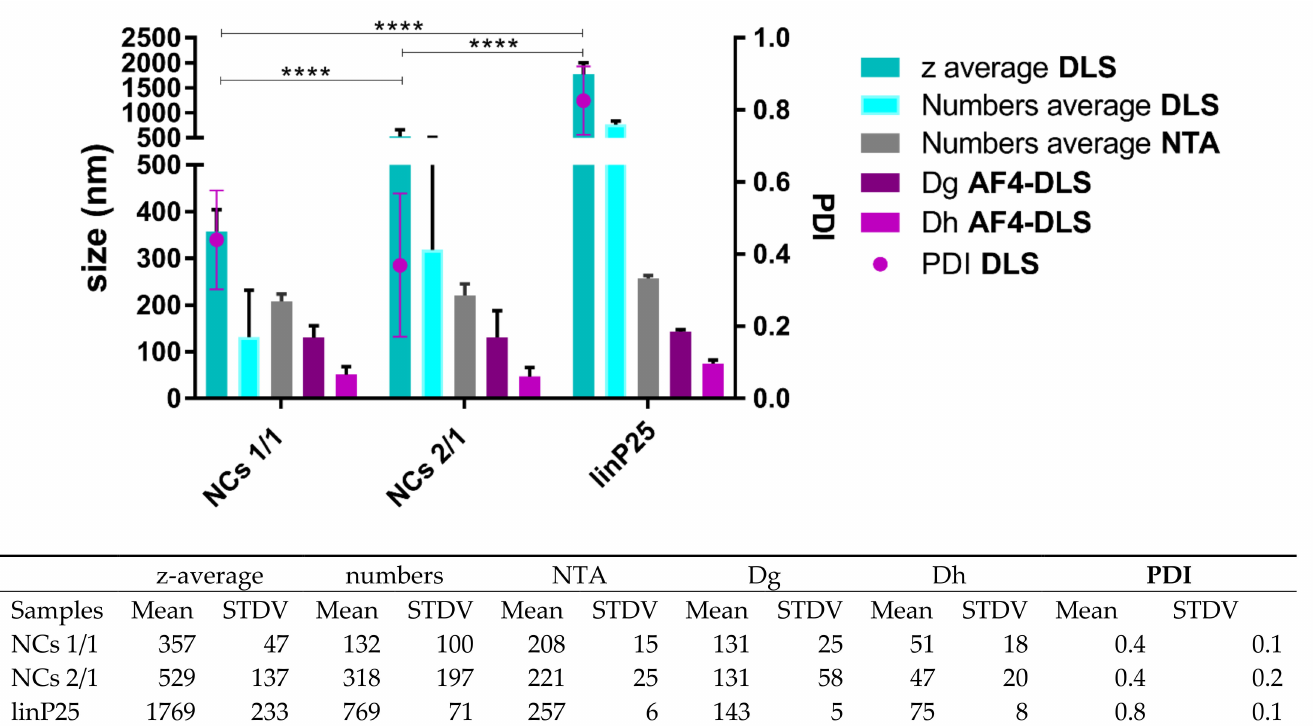
Figure 4. DLS (z-average and numbers), NTA and AF4-UV-MALS-RI-DLS (Dg and Dh) comparison of empty (linP25) and loaded NCs, graphical and table representation of the values at 0.01 mg/mL. n = 3; **** p <